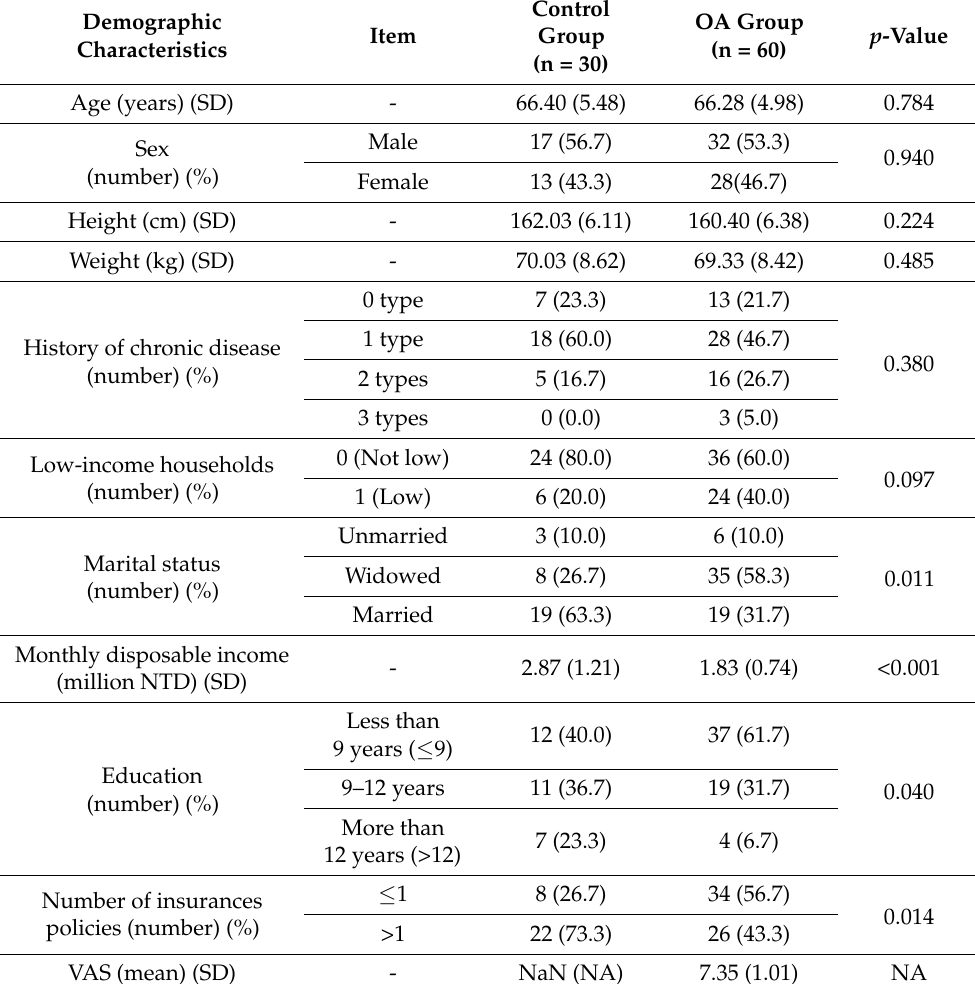
Table 1. Demographic characteristics of patients in the control and osteoarthritis